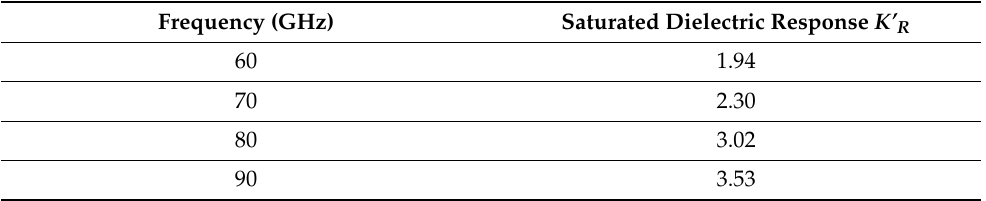
Table A1. Saturated dielectric response for 400 ppm ammonia concentration from published data.